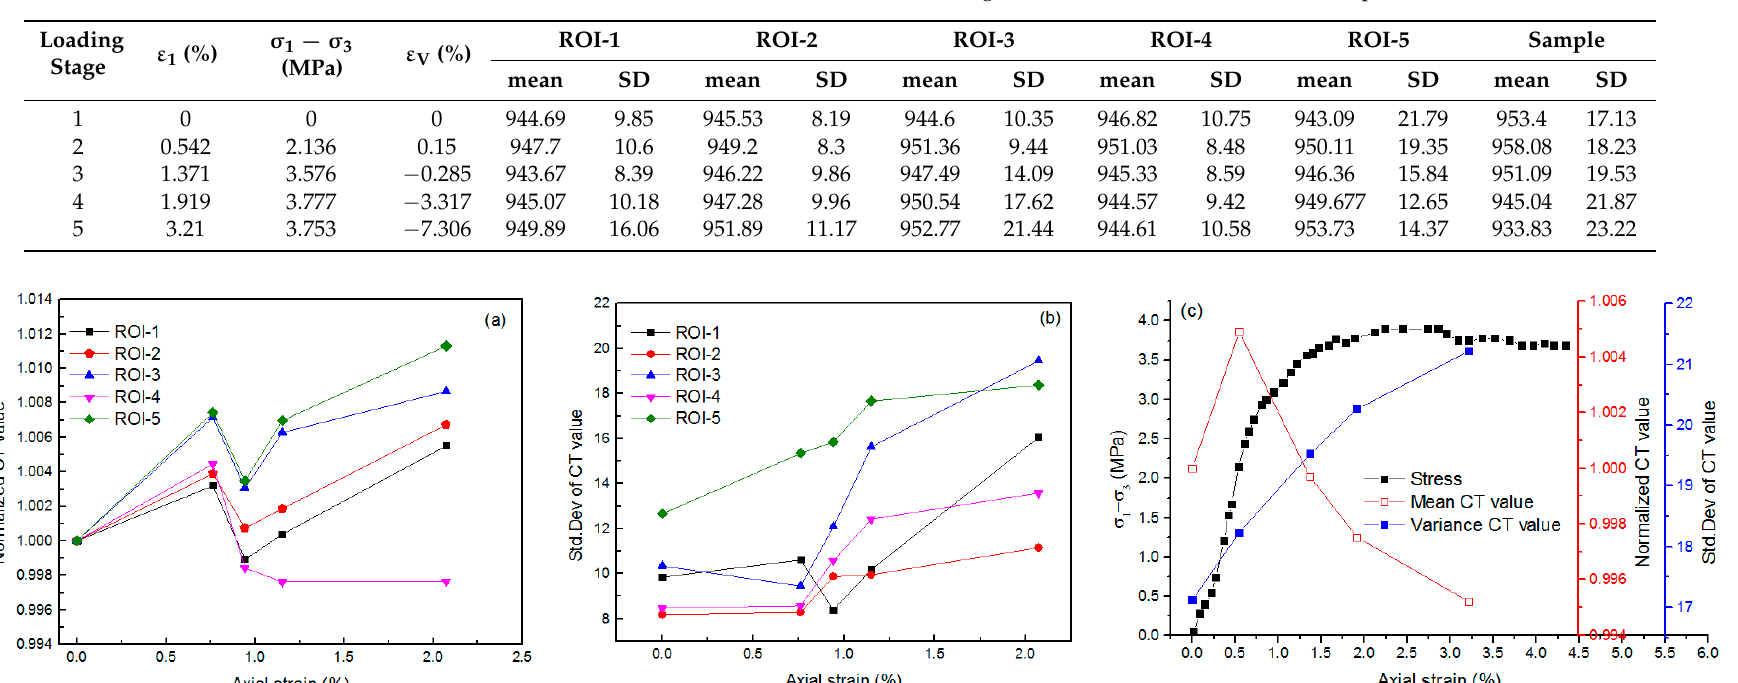
Figure 12. Changes of the CT values during sample deformation at the five scanning stages. ( a ) Evolution of the normalized CT value against axial strain for ROI 1–5; ( b ) Evolution of the variance CT value against axial strain for ROI 1–5. ( c ) Relationship between the normalized CT value, variance CT value, and axial strain for the entire CWRTB sample.